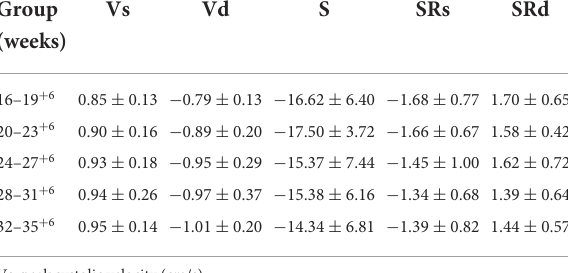
Vs,peaksystolicvelocity(cm/s). Vd,peakdiastolicvelocity(cm/s). S,strain(%). SRs,systolicstrainrate(S − 1 ). SRd,diastolicstrainrate(S − 1 ).